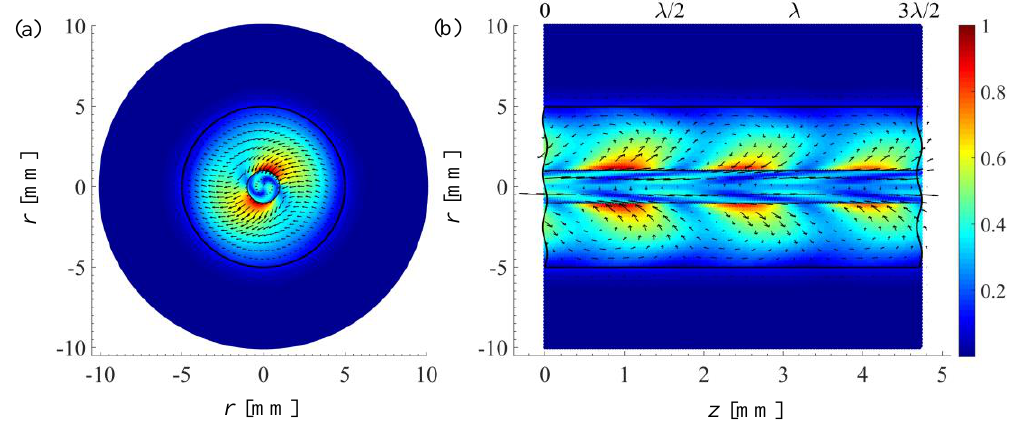
Figure 8. Electric field distributions of the fundamental “tube” mode in the transverse ( a ) and longitudinal ( b ) cross-sections of the waveguide filled with blood cells at a frequency of 50 GHz.